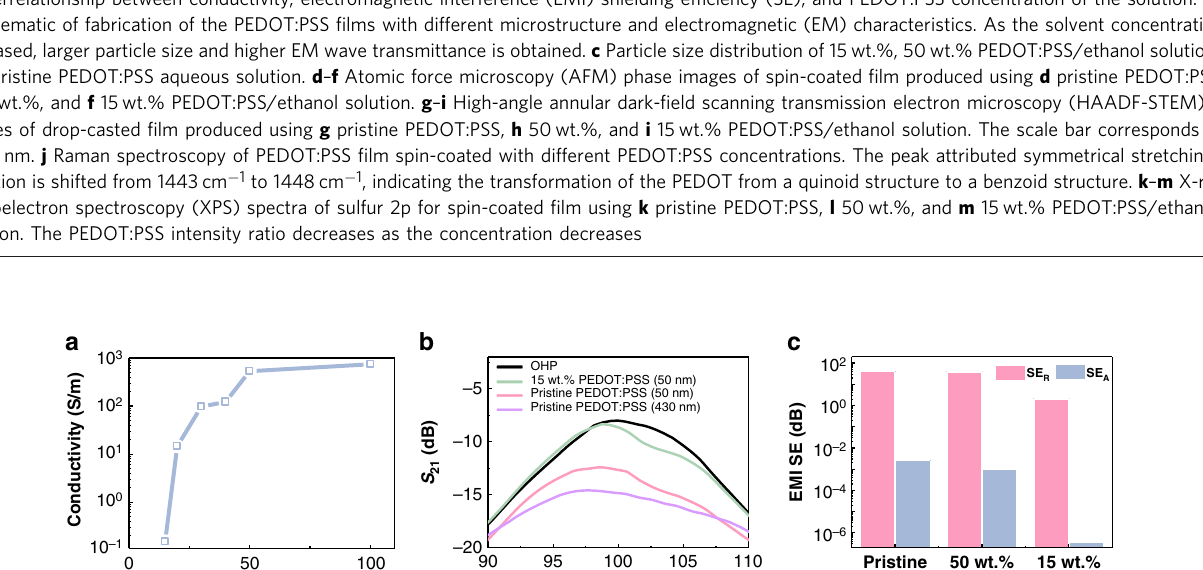
Fig. 2 Process and characteristics of MHz frequency-transparent poly(3,4-ethylenedioxythiophene):-poly(styrenesulfonate) (PEDOT:PSS) fi lm. a Interrelationship between conductivity, electromagnetic interference (EMI) shielding ef fi ciency (SE), and PEDOT:PSS concentration of the solution. b Schematic of fabrication of the PEDOT:PSS fi lms with different microstructure and electromagnetic (EM) characteristics. As the solvent concentration increased, larger particle size and higher EM wave transmittance is obtained. c Particle size distribution of 15 wt.%, 50 wt.% PEDOT:PSS/ethanol